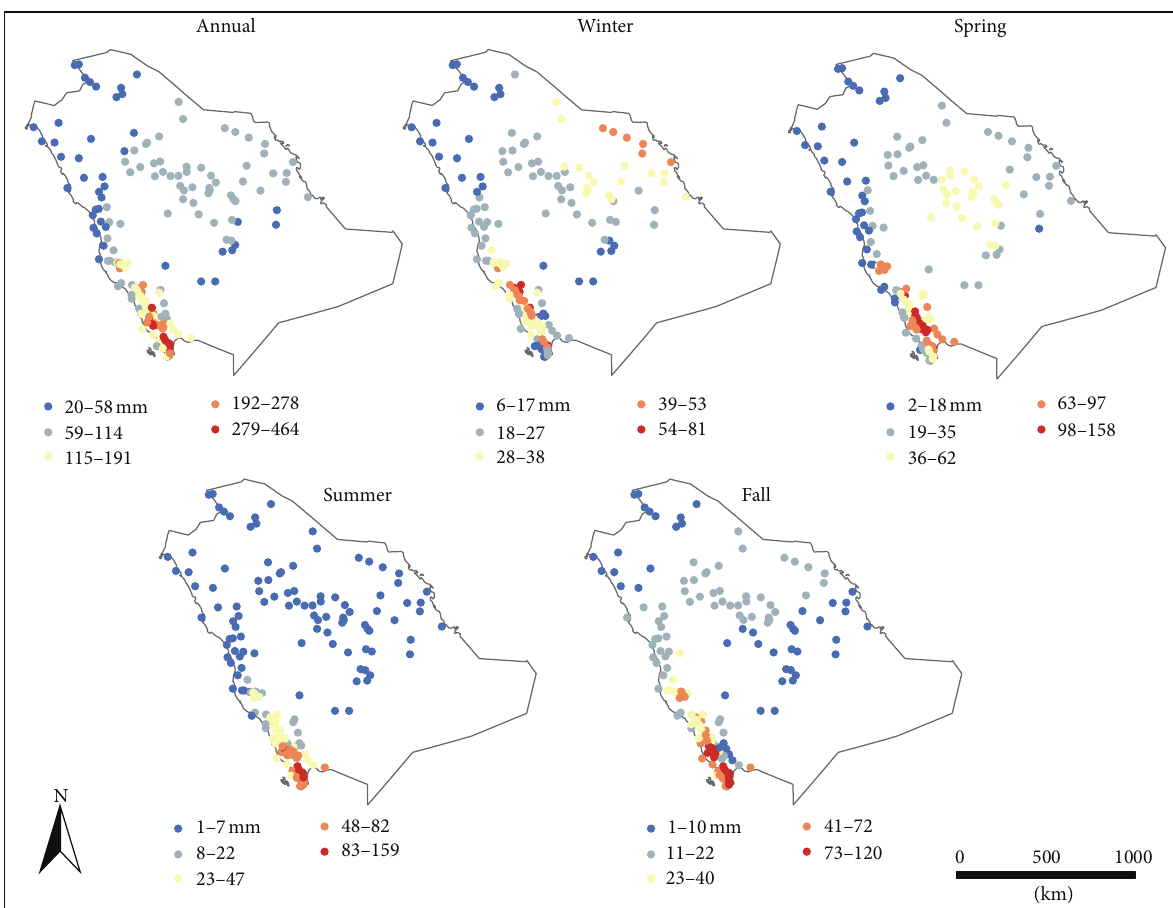
Figure 11: Estimation of mean annual and seasonal rainfalls in Saudi Arabia (1971–2005) using